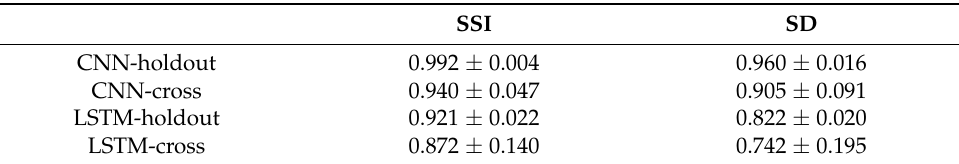
Table 4. The correlation coefficient of the sound-to-sound interval (SSI) and the sound duration (SD) between manual labeling and